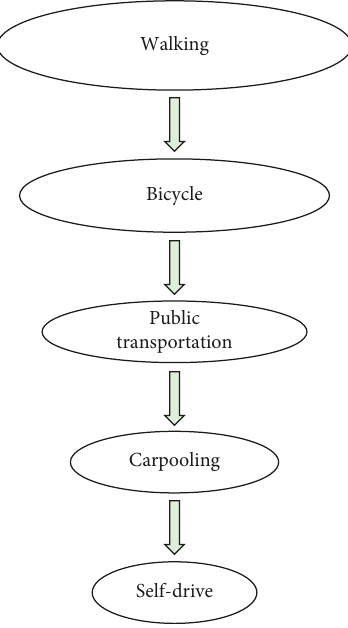
Figure 2: Green transportation